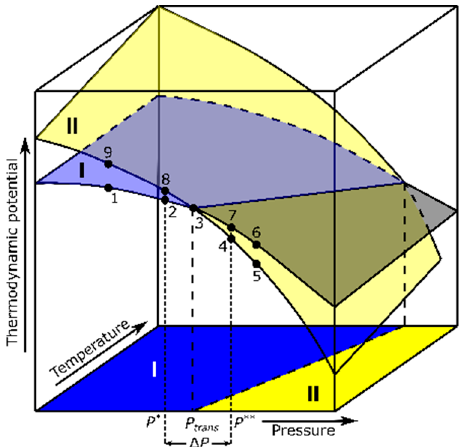
Figure 1. Thermodynamic-potential surfaces for two phases, I and II, as functions of pressure and temperature. The projection onto the P – T plane represents the phase diagram, whereas the line of intersection of the two surfaces corresponds to the I–II-phase-transition boundary. Black dots represent the stages of experimental isothermal compression or decompression routes. P * and P ** define the limits of the metastability range, while P trans denotes the equilibrium transition pressure.